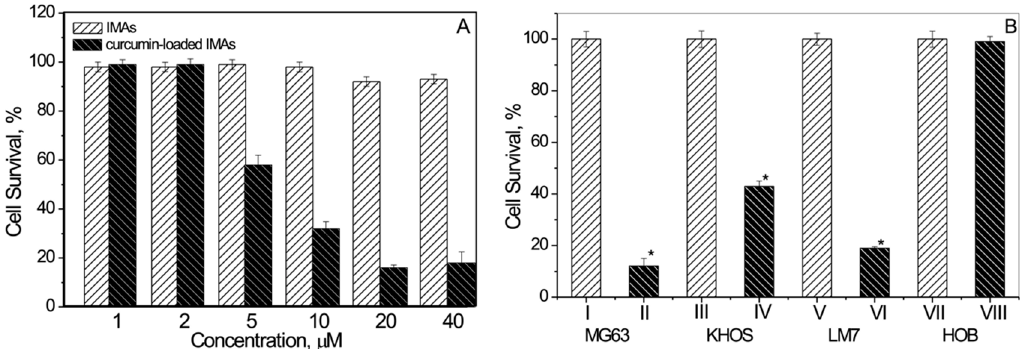
Figure 4. Osteosarcoma cell survival. MG63 osteosarcoma cells were treated with non-loaded micellar assemblies and micellar curcumin at different concentrations for 48 h ( A ); The effect of curcumin delivery on MG63 KHOS, LM7, and HOB cells at 72 h ( B ). Non-loaded micellar assemblies: I, III, V, VII; curcumin-loaded assemblies: II, IV, VI and VIII (from [126]).